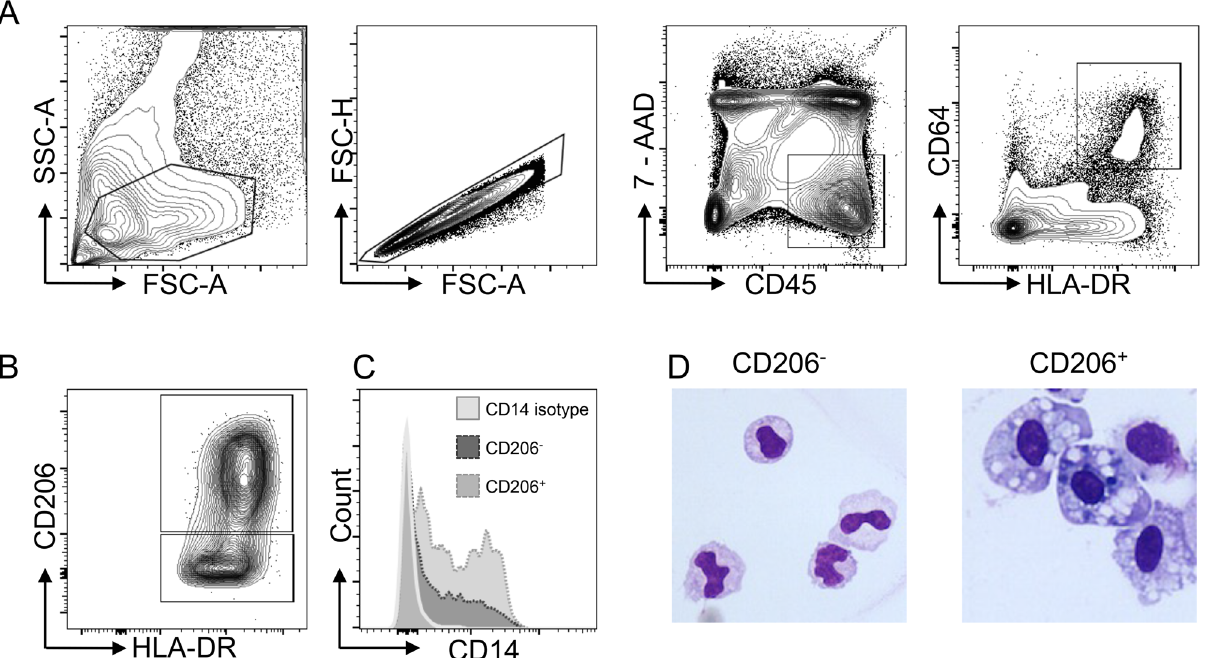
Figure 1. Identification of colonic human macrophage populations from healthy colon resections. ( A ) Gating strategy to identify human colonic macrophage populations by flow cytometry. Cells belonging to the monocyte: macrophage lineage reside within the live (7AAD-) single CD45 + CD64 + HLA-DR + leukocyte population. ( B ) Differential CD206 expression within CD64 + HLA-DR + population. ( C ) CD14 expression on CD64 + CD206 + and CD64 + CD206 − myeloid populations as compared to isotype control (histogram counts normalised to mode). ( D ) Morphological assessment of FACS-purified CD64 + HLA-DR + CD206 − and CD64 + HLA-DR + CD206 + cells. Data are representative of results from 10 humans, CD200R expression does not differ between monocytes, and CD206 − or CD206 + macrophages. This suggests that it may be expressed in humans at all stages of intestinal macrophage differentiation (Fig. 2A). A primary function of macrophages is to scavenge and phagocytose material from their external environ- ment. Expression of the C-type lectin receptor CD209 is elevated in CD64 + CD206 + macrophages compared to their CD64 + CD206 − counterpart, as previously reported in mature macrophage populations of the human ileum 13 . While the scavenger receptor CD163 is known to be present on blood monocytes 27 , it is expressed on CD64 + CD206 + macrophages at higher levels than their CD64 + CD206 − counterparts (Fig. 2A). Thus, supporting our previous findings, CD206 + intestinal macrophages appear to express higher levels of molecules that enable mature macrophages to perform their phagocytic functions. To better understand the relationship between blood monocytes and the CD64 + CD206 + and CD64 + CD206 − macrophage populations, we examined the levels of two markers highly expressed on blood monocytes (Fig. 2B), TREM1 and CCR2, with flow cytometry. Expression of TREM1 was found to be significantly lower on the CD64 + CD206 + macrophages than on blood monocytes, while the CD64 + CD206 − macrophage population appeared to express an intermediate level of TREM1 (Fig. 2B). There was also a trend towards lower expression of the chemokine receptor CCR2 in CD64 + CD206 + macrophages and CD64 + CD206 − macrophages, compared to blood monocytes, although this trend did not attain statistical significance. Therefore, as we expected, intestinal macrophages appear to lose expression of monocytic markers as they mature in the intestinal tissue. These data indicate that CD64 + CD206 + cells are likely to represent mature human intestinal macrophages while the CD64 + CD206 − phenotype is consistent with an earlier differentiation state from blood monocytes that have recently entered the intestine. Work by Bernardo et al. 14 . proposed a similar maturation process in the development of intestinal macrophages from monocytic precursors. Bernardo reports initial expression and then gradual loss of CD11c as a marker of monocyte-macrophage differentiation. When we gated CD45 + CD64 + CD14 + macrophages, as described by Bernardo, we also observed cells with differential CD11c expression (Supplementary Fig. 1). Further analysis of the CD11c and CD206 expression in this macrophage subpopulation revealed a CD11c hi sub-population expressing low levels of CD206. Gating on CD45 + CD64 + MHC II + cells, using our usual strategy, also enables identification of this CD11c hi CD206 − population of intestinal macrophages. These data are consistent with the idea that CD206 − cells are an earlier stage of differentiation than their CD206 + counterparts. The CD206 + cells can then be subdivided on the basis of their CD11c expression, as previously described 14 . IL‑10 expression by colonic macrophages correlates with CD206 expression. To understand how the functions of CD64 + CD206 + and CD64 + CD206 − macrophages differ, we examined their expression